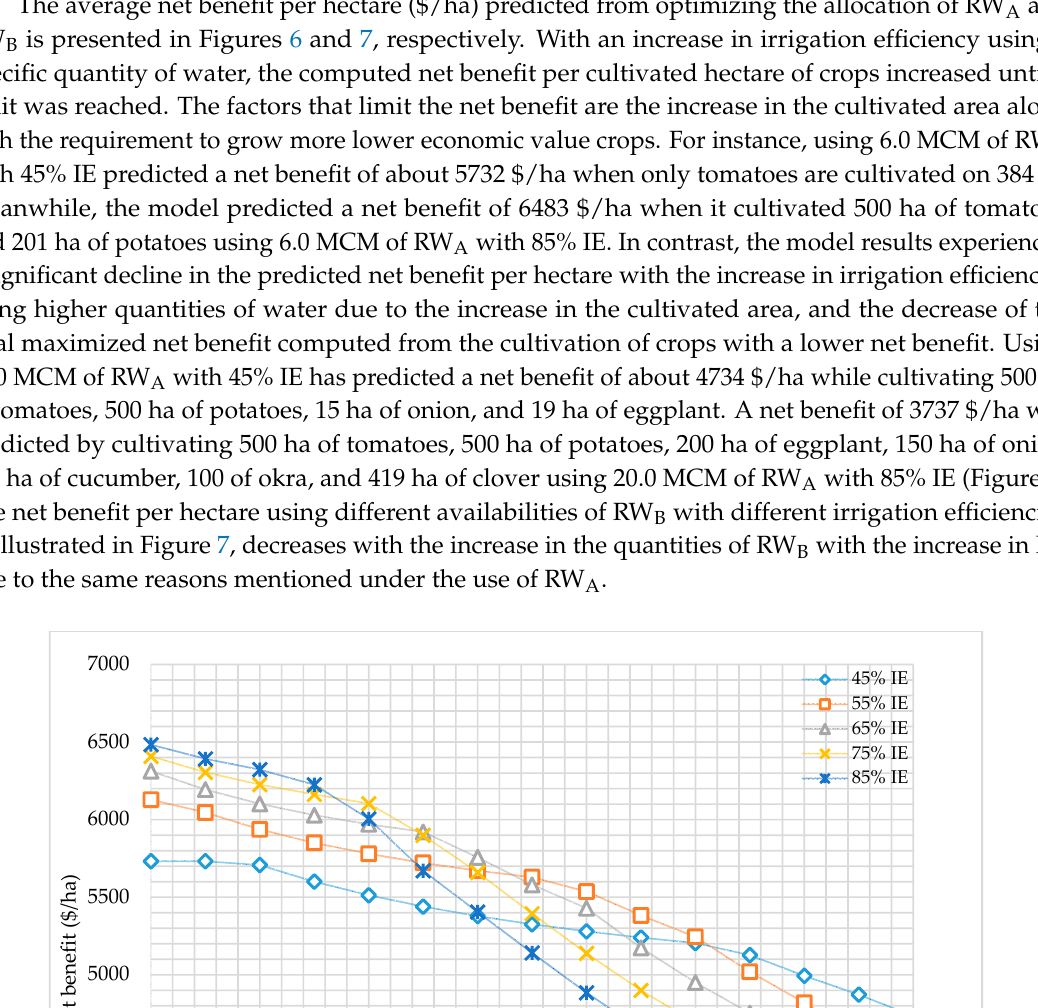
Figure 7. Net benefit per hectare ($/ha) predicted using reclaimed water type B (RW B ) with five different irrigation efficiencies (IEs). The cultivated crops using different availabilities of RW A with 45, 65, and 85% IEs are presented in Figures 8–10, respectively. There are 14 different types of crops available for cultivation using RW A as listed in group A in Table 1. Each crop has its own evapotranspiration value, selling price, production cost, and yield per hectare. Starting with 6.0 MCM with 45% IE, the model predicted cultivation of 384 ha of tomatoes. Tomato is the crop which satisfied the highest net benefit per hectare as compared to the other competitive crops in Table 1. All of the 84 cultivated farms of the